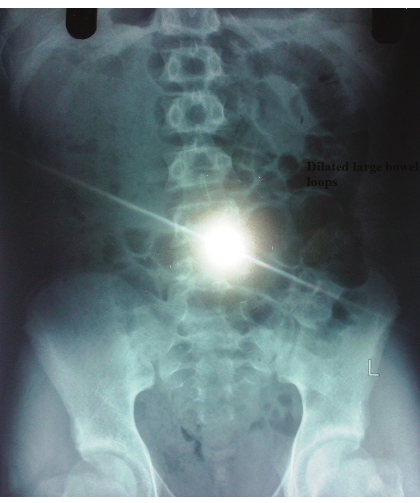
Figure 1: Erect abdominal X-ray showing dilated large bowel loops.